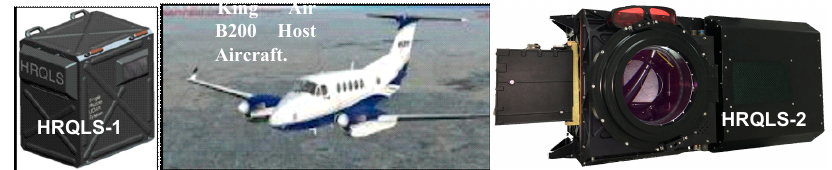
Figure 5. Moderate altitude HRQLS-1 and HRQLS-2 lidars and the King Air B200 host aircraft.